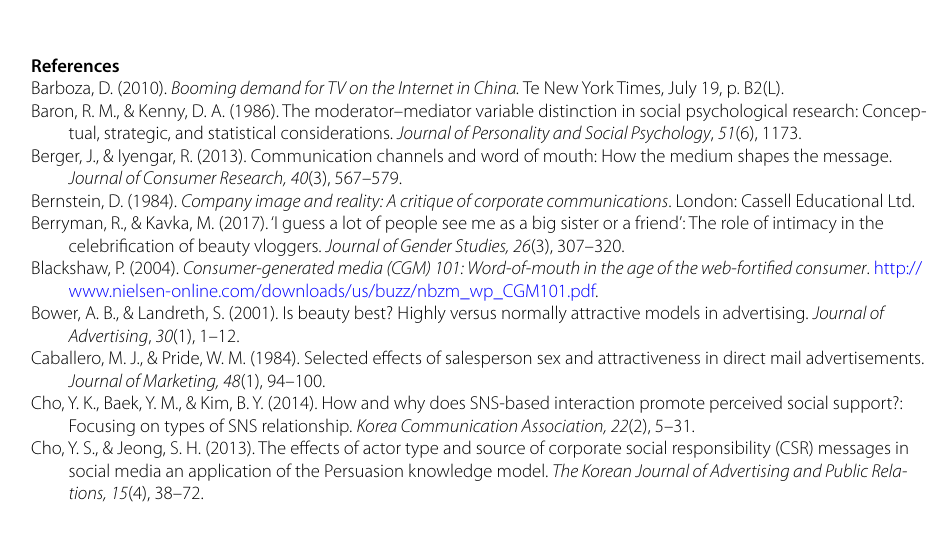
Fig. 3 <Vlog-explicit exposure type> (The source of the video: https ://www.youtu be.com/watch ?v IMSaw k&t =